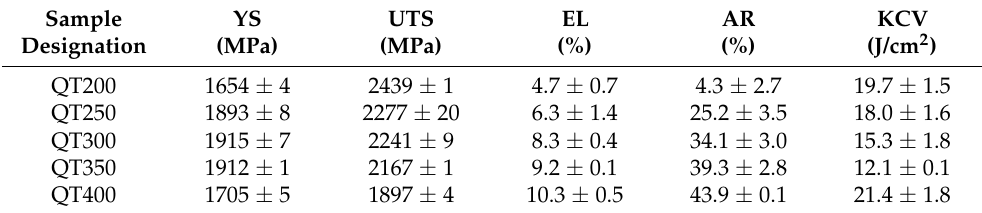
Table 4. Results of tensile testing, conventional quenching and tempering